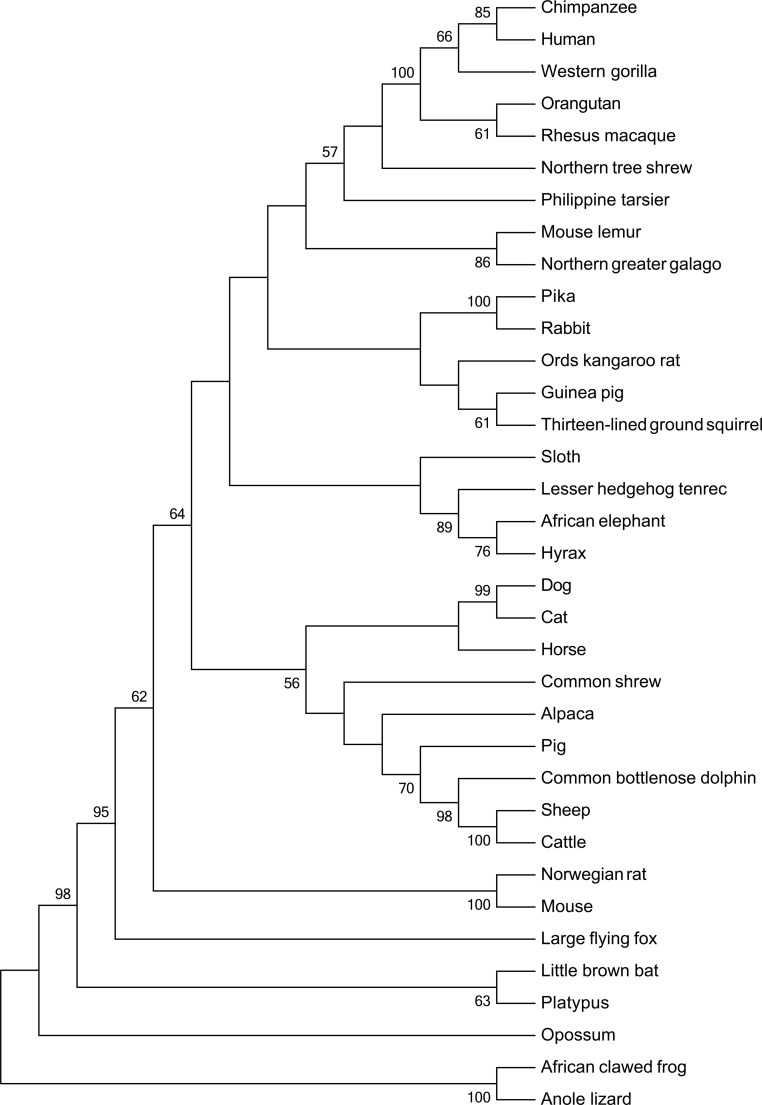
Neighbor-joining phylogenetic tree of 35 species on FTO coding sequences showing the evolutionary relationship.The bootstrap consensus tree inferred from 1000 replicates is generated to present the evolutionary relationship among 35 species on FTO coding sequences which were retrieved from Ensembl or NCBI. Accession numbers are listed at S1 Table. Alignment was carried out by ClustalW (1581 nucleotides left) and phylogenetic tree is constructed by neighbor-joining method in MEGA6. Branches corresponding to partitions reproduced in less than 50% bootstrap replicates did no display. This tree works as the initial tree for further PAML analysis.